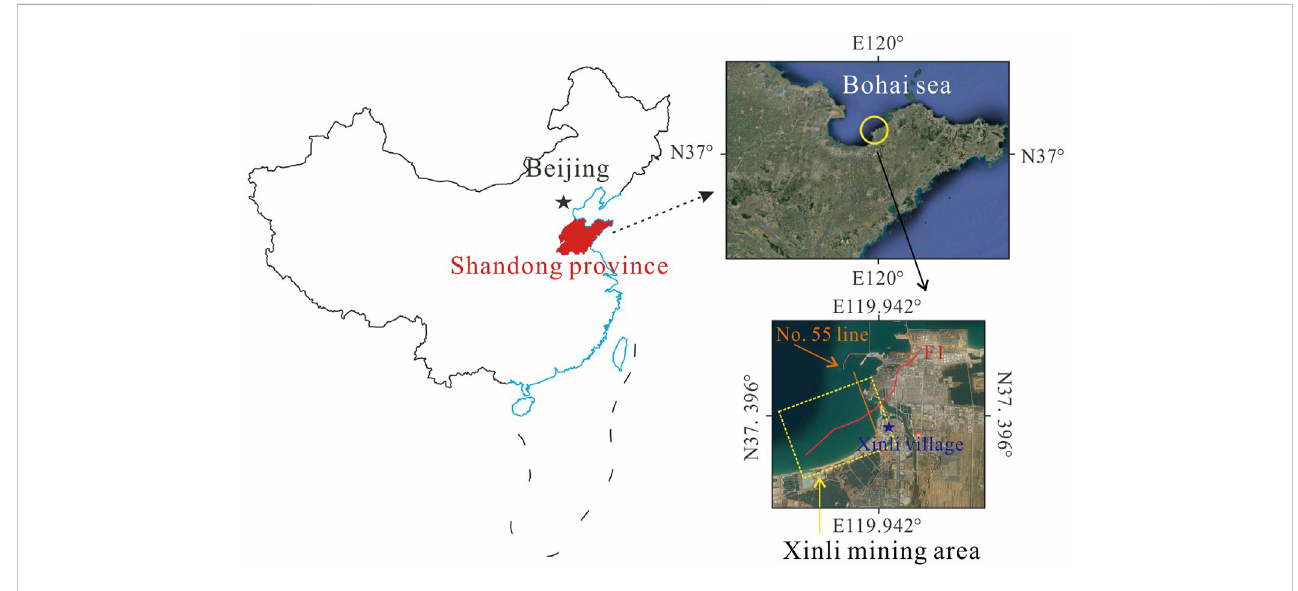
FIGURE 1 Location of the study